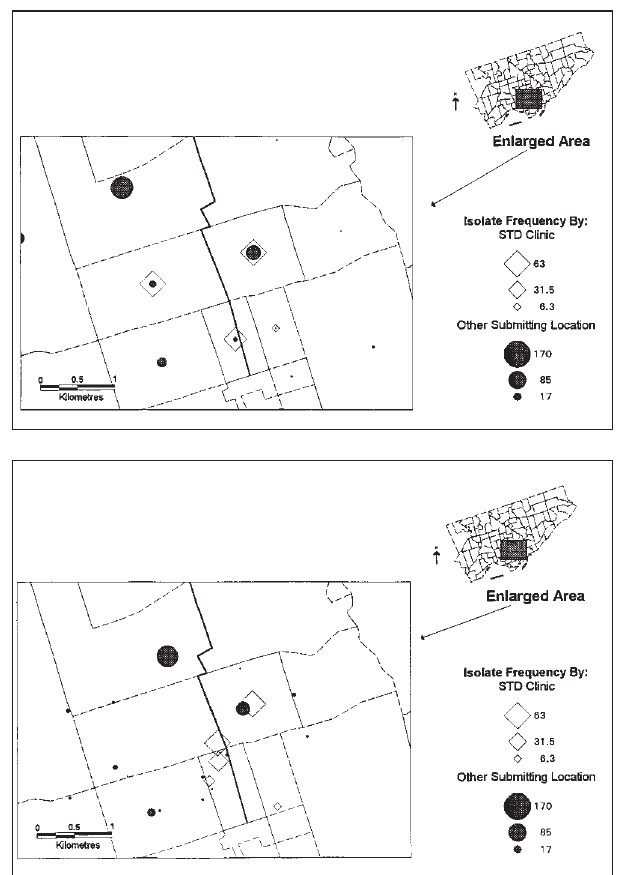
Figure 3) Top Spatial distribution of penicillinase-producing isolates of Neisseria gonorrhoeae (PPNG) and tetracycline-resistant N gonor- rhoeae (TRNG) by submitting locations in Toronto, 1988 to 1992, us- ing three-digit postal codes. Bottom Spatial distribution of PPNG and TRNG by submitting locations in Toronto, 1988 to 1992, using six- digit postal codes. Symbols (circles and boxes) are proportionally graduatedaccordingtothenumberofisolatesreportedateachsubmit- ting location. Forward sortation area boundaries are included as a frame of reference. STD Sexually transmitted